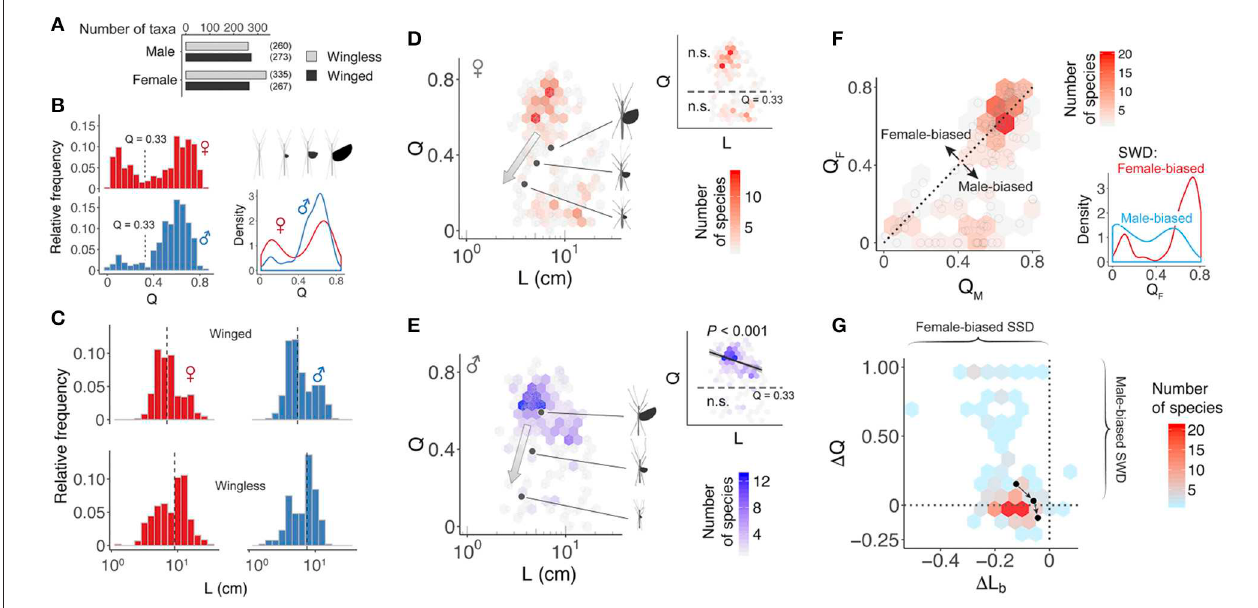
FIGURE 3 | Variation in wing and body size among stick insects. (A) Number of winged and wingless species, as grouped by the two sexes. (B) Relative frequency distribution and density of relative wing size (Q) for winged taxa. The vertical dashed lines indicate a region of phenotypic space that few species occupy. (C) Relative frequency distribution of body size (L). Black dashed lines denote median values. (D,E) Scatter plots of Q vs. L for winged stick insects, indicating bimodal distributions. The color of overlaid hexagons represents the number of species, as scaled by the heat map inset. Insets show results of generalized least squares (GLS) regression models (trend line with 95% C.I.) for short- and long-winged insects, as categorized by the cutoff Q defined in (A) . An inverse correlation between Q and L is found in long-winged males. (F) Scatter plot of female relative wing size vs. male relative wing size ( N = 183 species). The color of overlaid hexagons represents the number of species for each parameter combination. The majority (80%) of female-biased SWD (i.e., the area above the dashed line) is associated with medium-length to long wings (Q F > 0.5), as indicated by the increasing density of female-biased SWD in long-winged females (Q > 0.4) (inset). (G) Scatter plot of SWD index vs. SSD index, showing the predominance of female-biased SSD and continuous variation in SWD (57% male-biased and 43% female-biased). For (D,E,G) , the three dark dots represent subspecies of the A. tanarata group, showing sex-specific trends of wing and body size reduction with increasing altitude (as indicated by